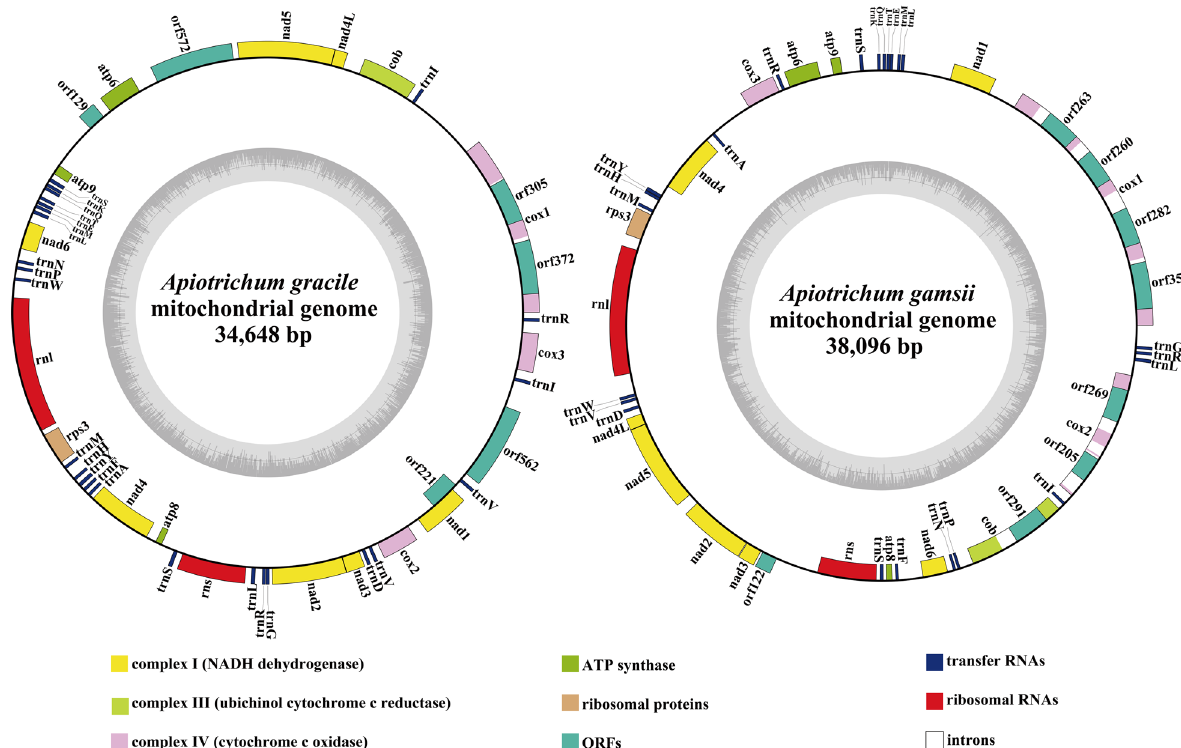
Fig. 1 Circular maps of the two Apiotrichum mitogenomes. Genes are represented by different colored blocks. Colored blocks outside each ring indicate that the genes are on the direct strand, while colored blocks within the ring indicates that the genes are located on the reverse strand. The inner grayscale bar graph shows the GC content of the mitochondrial sequences. The circle inside the GC content graph marks the 50%